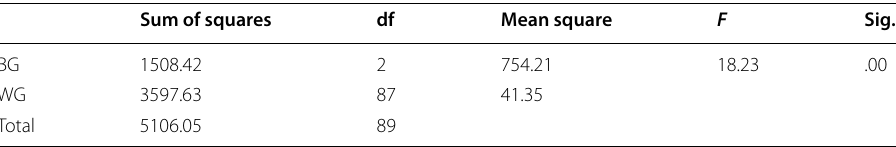
Table 14 Inferential statistics of cognitive load posttest of all groups Sum of squares df Mean square F Sig. BG 1508.42 WG 3597.63